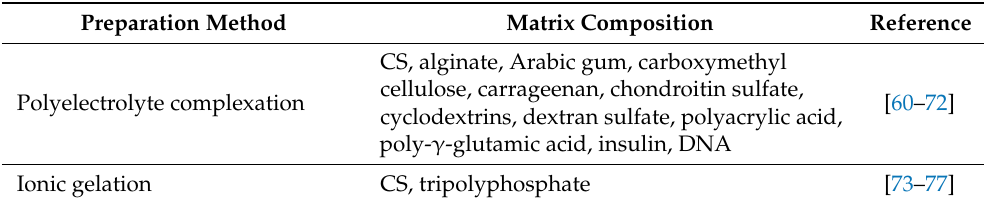
Table 1. Chitosan nanoparticle preparation methods